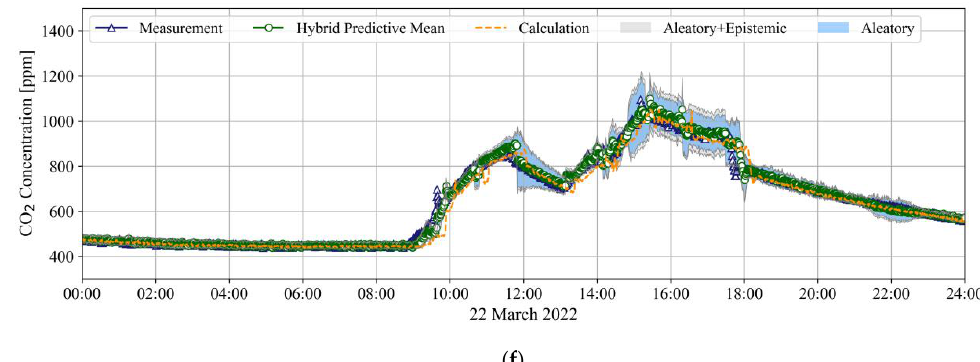
Figure 3. Time–series forecasting results obtained using the hybrid model and mass balance equation for the LR zone for the prediction horizons of ( a ) 5 min, ( b ) 10 min, and ( c ) 15 min for March 21 and ( d ) 5 min, ( e ) 10 min, and ( f ) 15 min for 22 March.